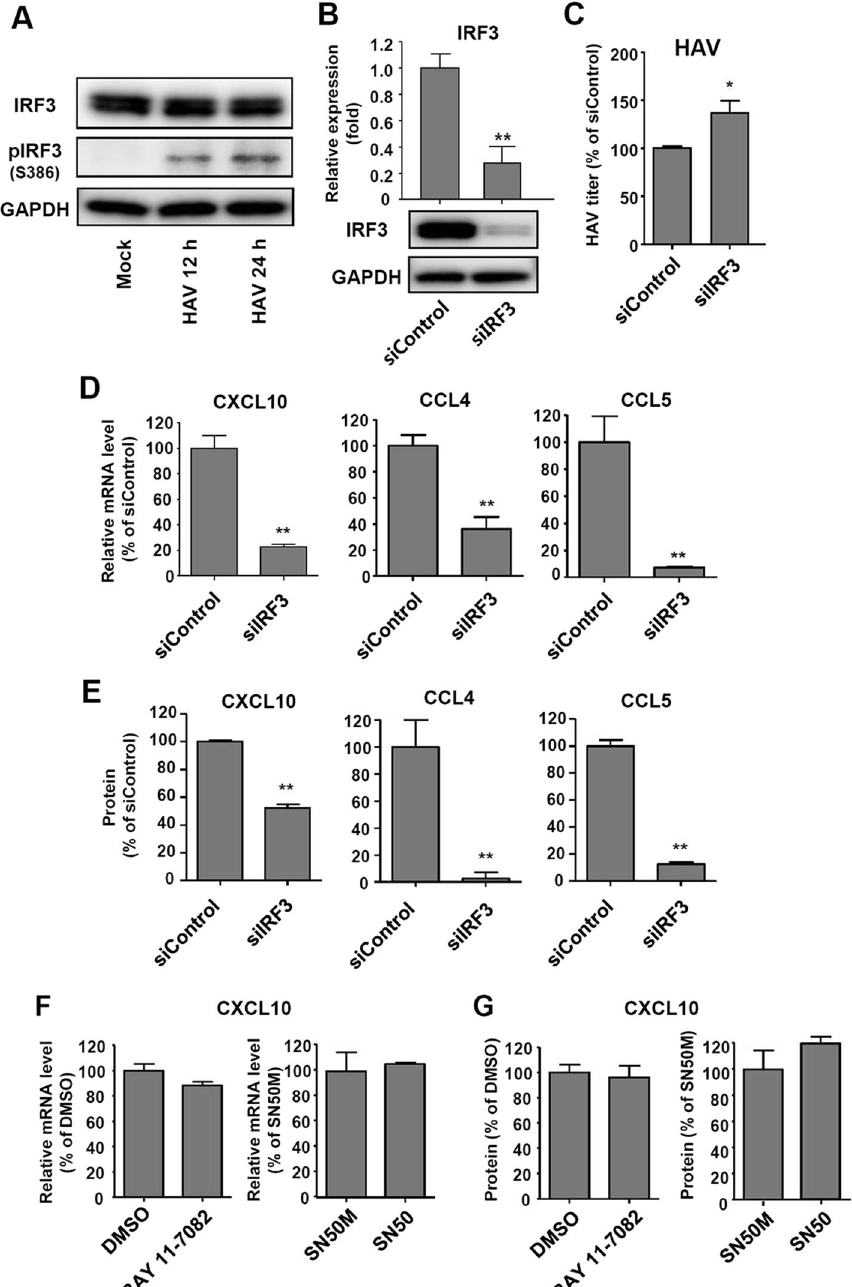
Figure 6. IRF3-dependent production of CCL4, CCL5, and CXCL10 in HAV-infected cells. ( A ) HepG2 cells were infected with HAV at 500 GE/cell. Cell pellets were harvested 12 and 24 hours after infection. IRF3 and phospho-IRF3 (S386) were detected via immunoblotting. Data are representative of two independent experiments. ( B ) HepG2 cells were transfected with siControl or siRNA targeting IRF3 (siIRF3). Efficient knock-down by siIRF3 was confirmed via real-time qPCR (upper) and immunoblotting (lower). Bar graphs represent the means ± s.e.m. (n = 3). Unpaired t-tests were performed. ** P < 0.01 compared to siControl. ( C – E ) HepG2 cells were transfected with siControl or siIRF3. After 72 hours, cells were infected with HAV at 200 GE/cell. Cell pellets and culture supernatants were harvested 24 hours after infection. Intracellular HAV RNA titer was examined by real-time qPCR ( C ). Real-time qPCR ( D ) and ELISA ( E ) were performed to examine the production of CXCL10, CCL4, and CCL5. Bar graphs represent the means ± s.e.m. (n = 3). Unpaired t-tests were performed. * P < 0.05, ** P < 0.01 compared to siControl. ( F , G ) HepG2 cells were treated with 2 μ M BAY 11–7082 or DMSO, or 50 mg/L SN50M or SN50. After 24 hours, cells were infected with HAV at 200 GE/cell. Cell pellets and culture supernatants were harvested 24 hours after HAV infection. Real-time qPCR ( F ) and ELISA ( G ) were performed to examine the production of CXCL10. Bar graphs represent the means ± s.e.m. (n = 3). Unpaired t-tests were